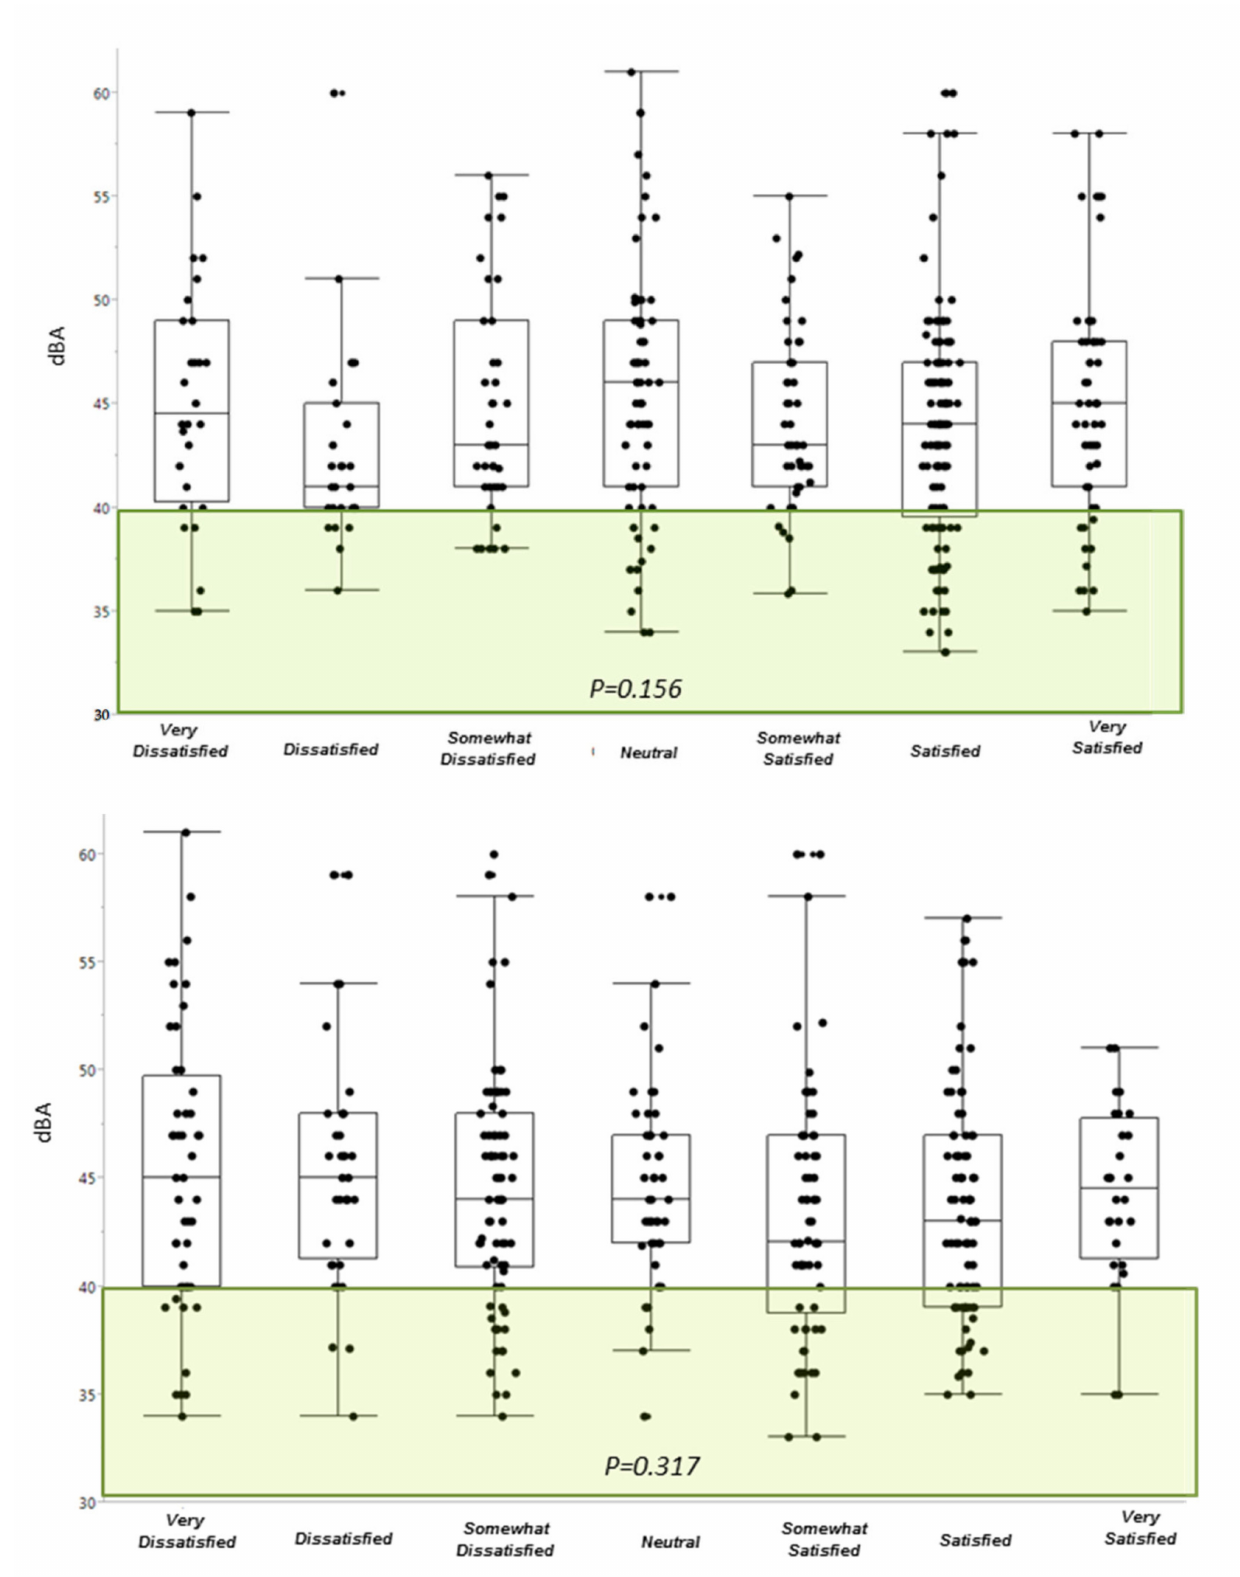
Figure 3. ( Top ) Noise Criteria by user satisfaction with background noise; ( bottom ) Noise Criteria by user satisfaction with frequency of distraction from other